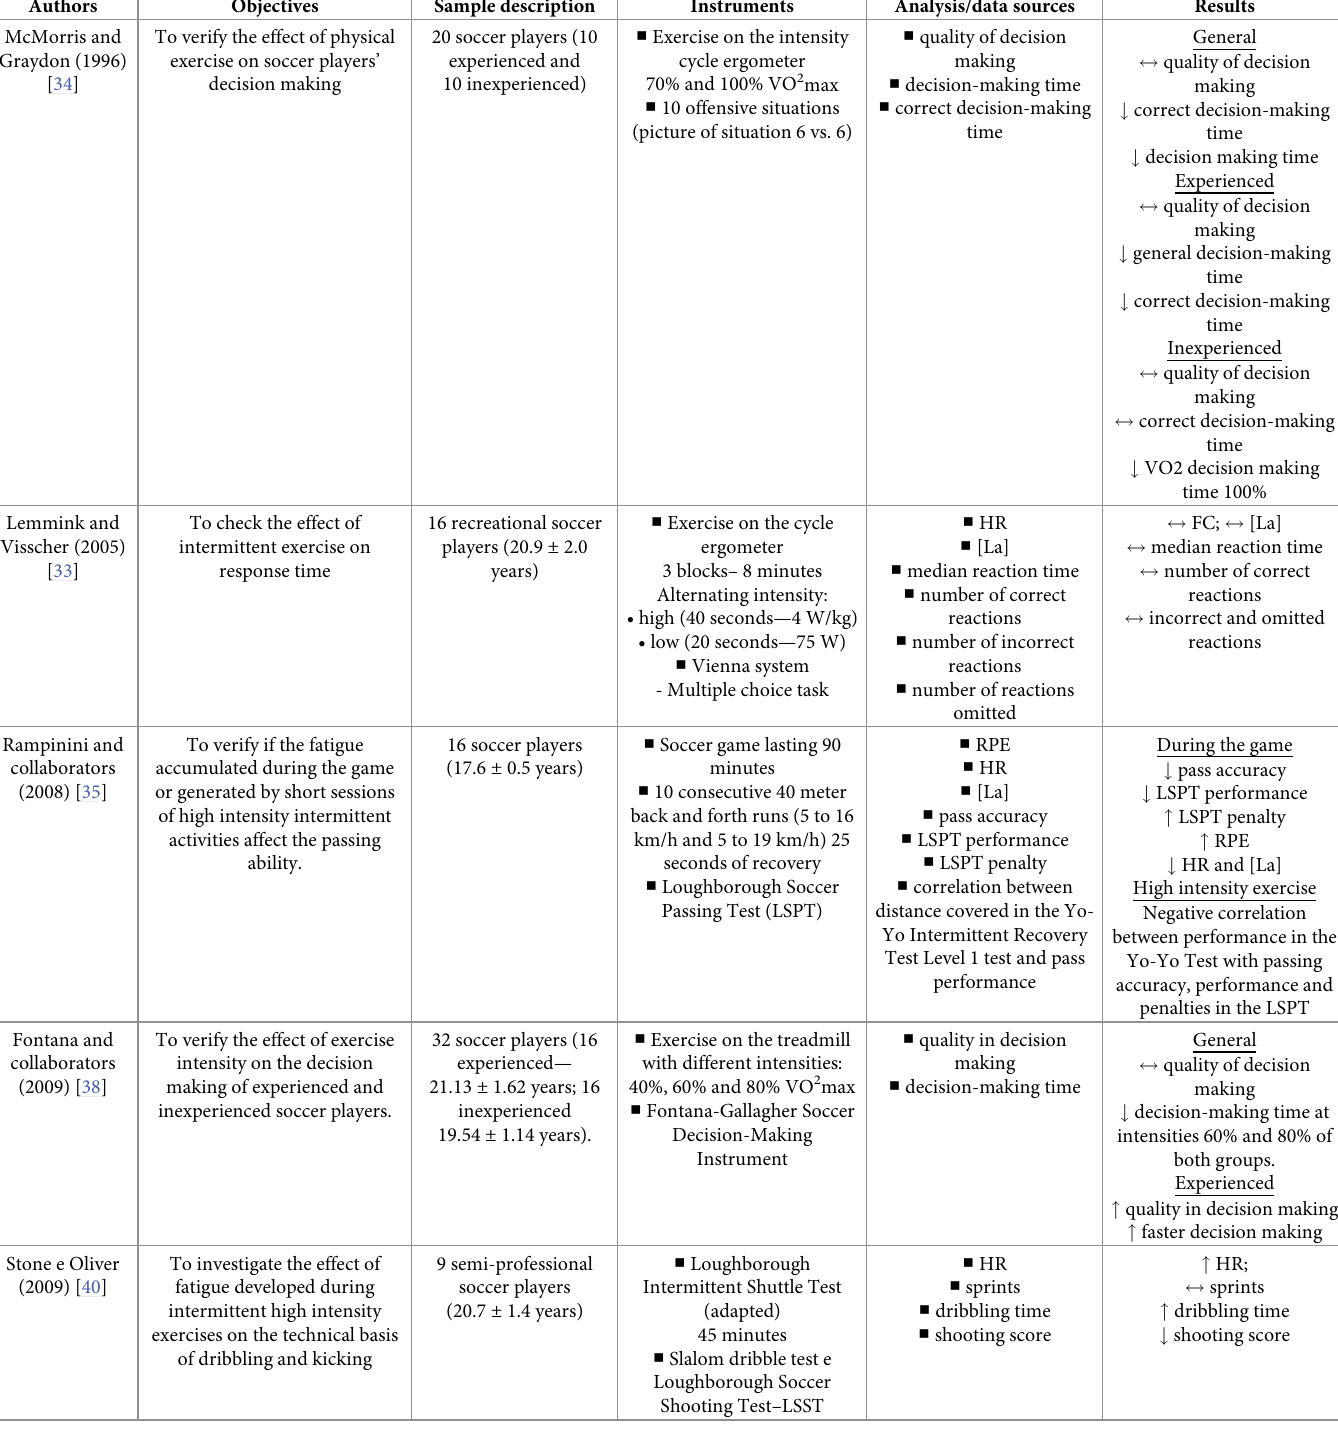
Table 5. Summary of studies included in the systematic